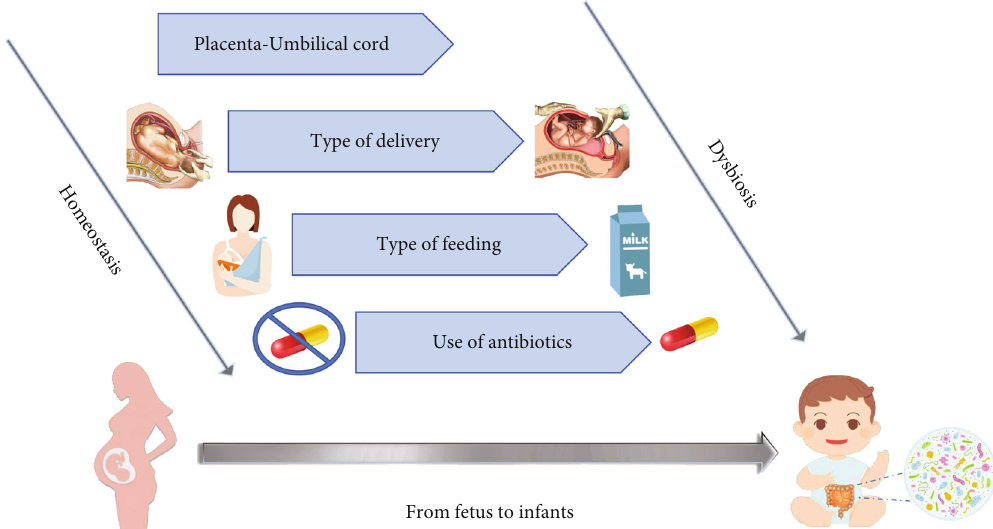
Figure 1: Factors that determine the development of the microbiota in infants. The development of the microbiota begins during pregnancy and continues after birth with exposure to environmental factors. To the left of the fi gure are factors associated with homeostasis. To the right of the fi gure are factors related to